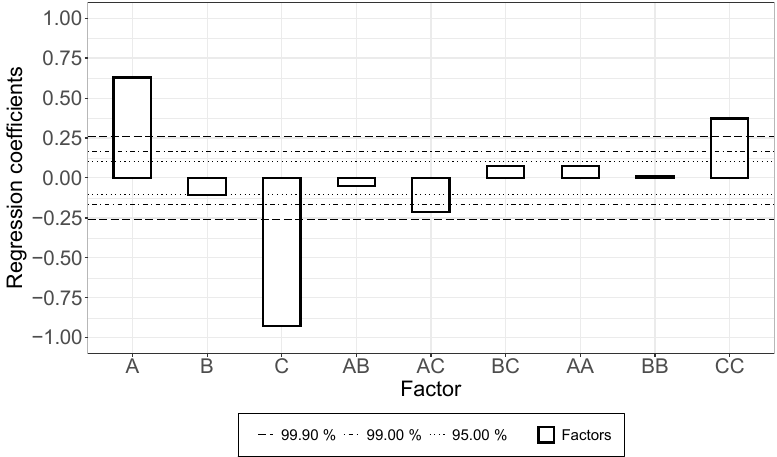
Figure 7. Effects of polymer concentration (A), coating time (B), coating speed (C), interdependences, and nonlinear effects on dry layer thickness in coating of PI ‐ based dispersions.